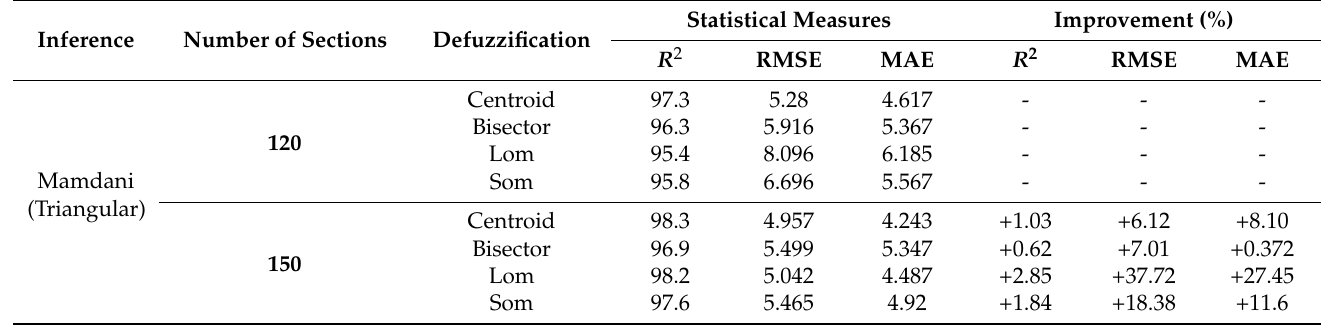
Table 7. Comparison of the fuzzy inference systems’ configurations for 120 and 150